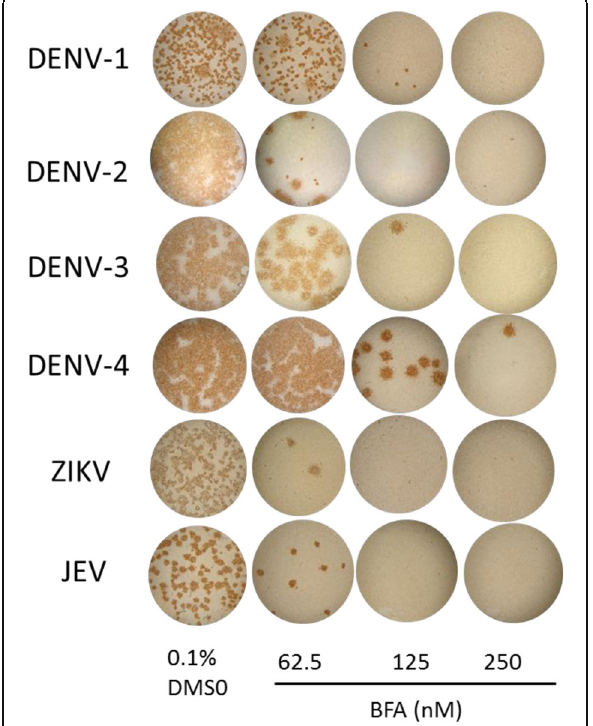
Fig. 3 Inhibitory effect of BFA on all DENV serotypes, ZIKV, and JEV. Vero cells in 96-well plates were infected with DENV-1, 2, 3, and 4, ZIKV, or JEV in the presence of BFA at indicated concentration or 0.1% DMSO. Forty-eight hours after infection/treatment, ICFs were harvested and then infected into fresh cells for focus reduction assay as described in the “ Materials and methods ” section. The image shown is a representative result from two